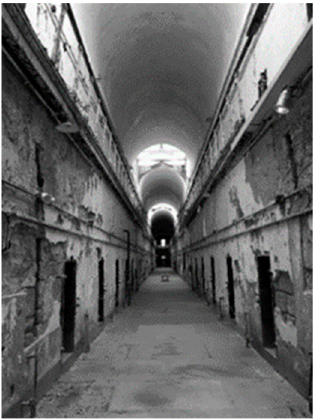
Figure 3. A view of prison hallway at the Eastern Penitentiary Museum.